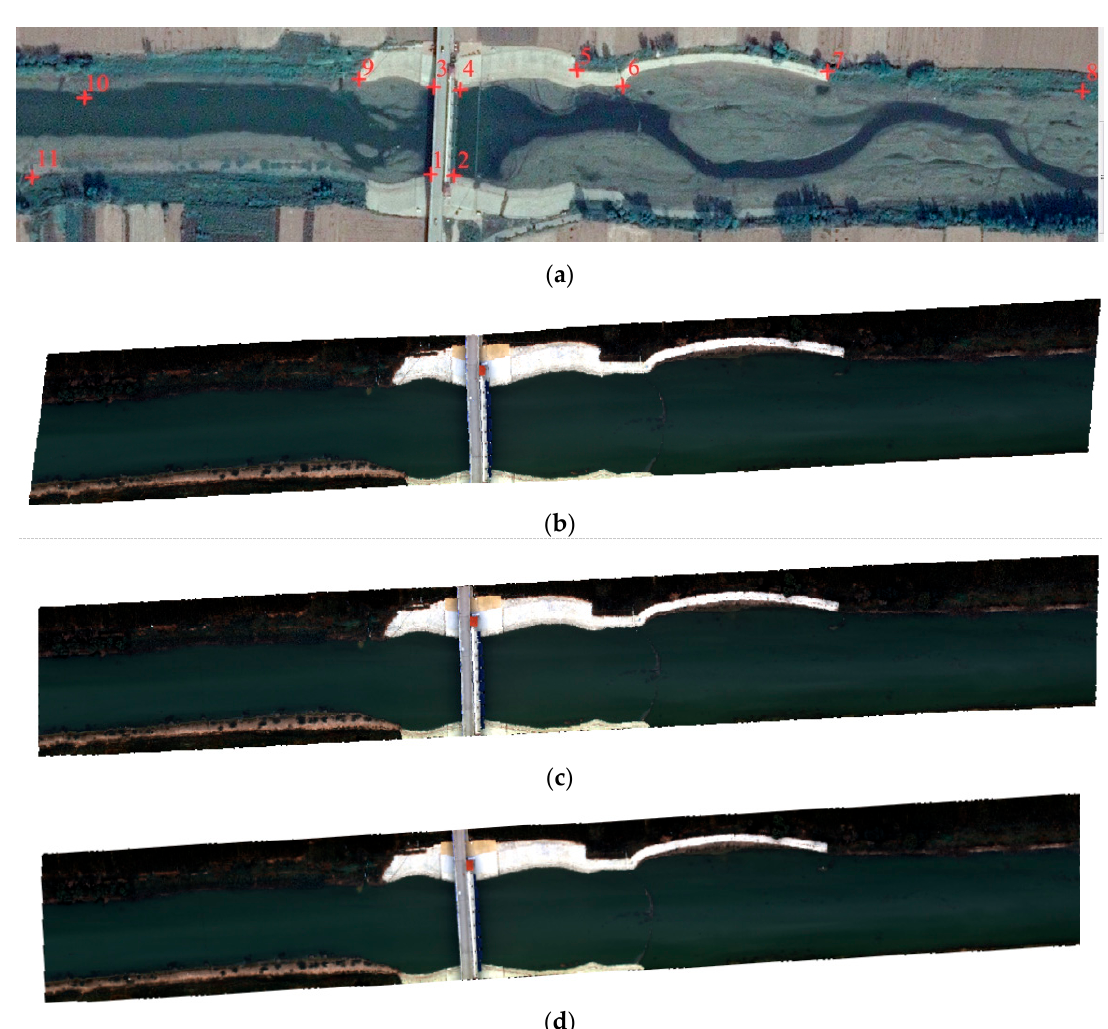
Figure 6. River course GCPs and geometric rectified results: ( a ) GCPs on GE image; ( b ) CSSF method with 11 GCPs; ( c ) POS-based method without GCP; ( d ) POS-based geometric rectification method with 4 GCPs that labeled as 2, 6, 8 and 11 on Figure 5a. Table 3. Geometric rectification accuracy (units in meters) of the river course